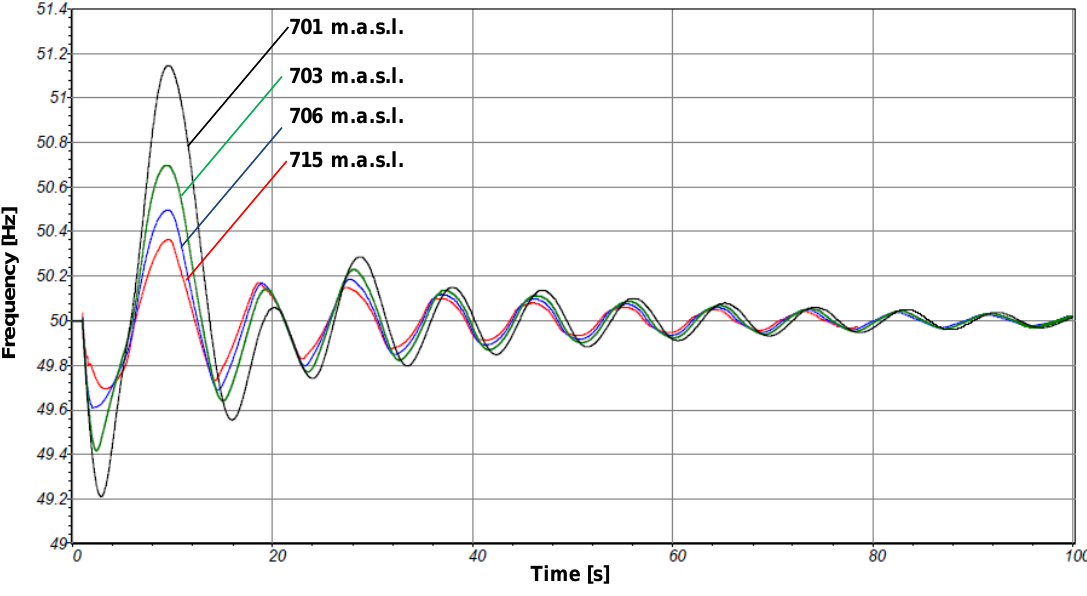
Figure 13. Frequency in the power system after a wind generator trip for different upper reservoir levels (20 s) after a 2.3 MW wind generator trip.